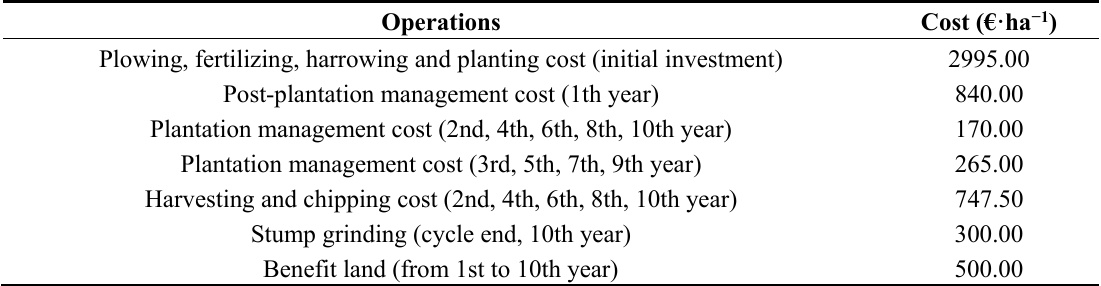
Table 4. Average plantation and management costs (€·ha − 1 ), on the productive cycle of the SRC plantation (10 years).